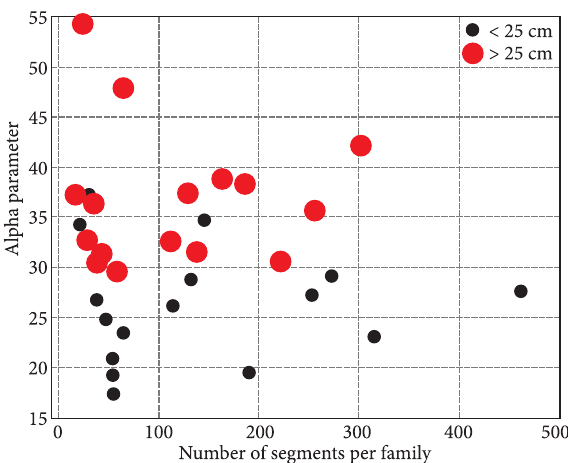
Fig. 6. Alpha parameter and the number of segments per family